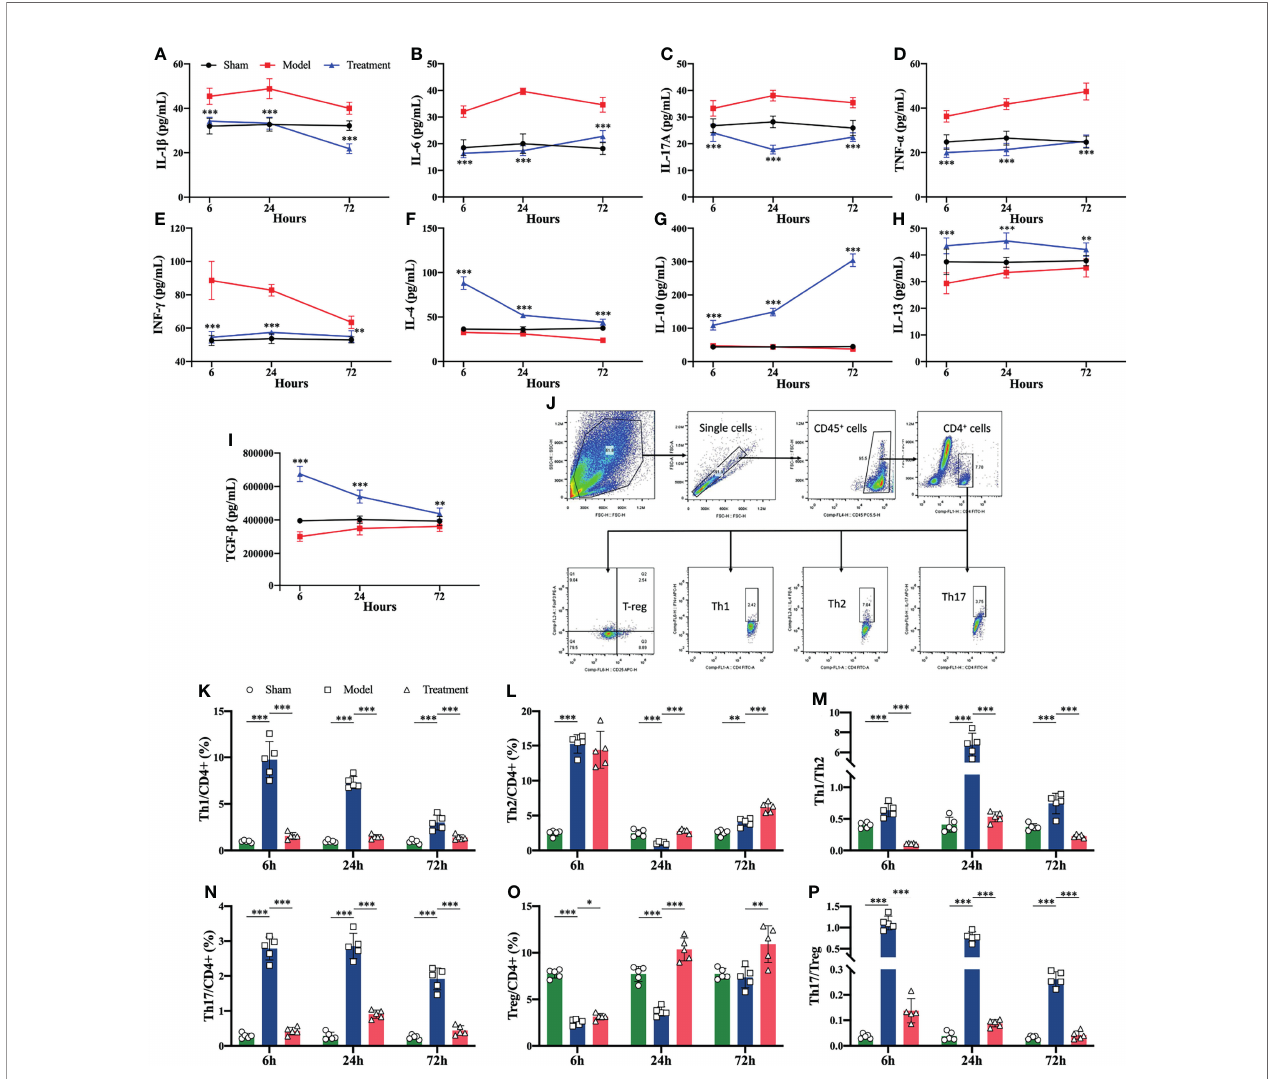
FIGURE 3 | In fl ammatory cytokine levels and proportions of Th cell subpopulations in peripheral blood of rats in each group. (A – I) In fl ammatory cytokine levels in serum of rats in each group (*compared with the model group); (J) circle gating strategy for fl ow cytometry analysis of peripheral blood Th cell proportions; (K, L, N, O) fl ow analysis of the proportions of Th1, Th2, Th17, and Treg cells in peripheral blood as a percentage of CD4 + T cells; (M) ratio of Th1/Th2 in peripheral blood of rats in each group; (P) ratio of Th17/Treg in peripheral blood of rats in each group. n=5, *p<0.05, **p<0.01,